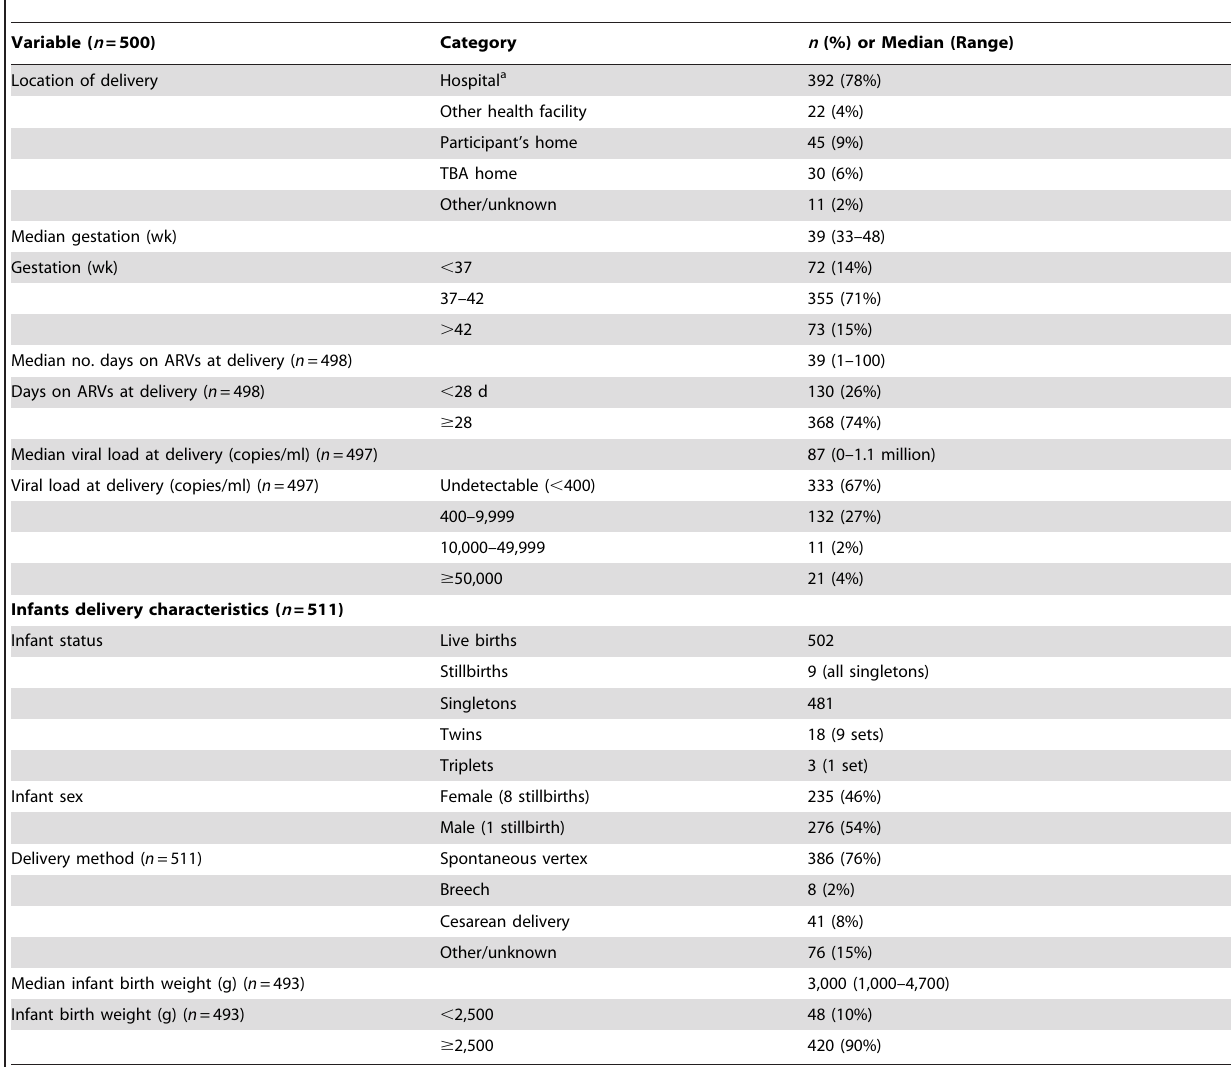
Table 2. Maternal and infant delivery